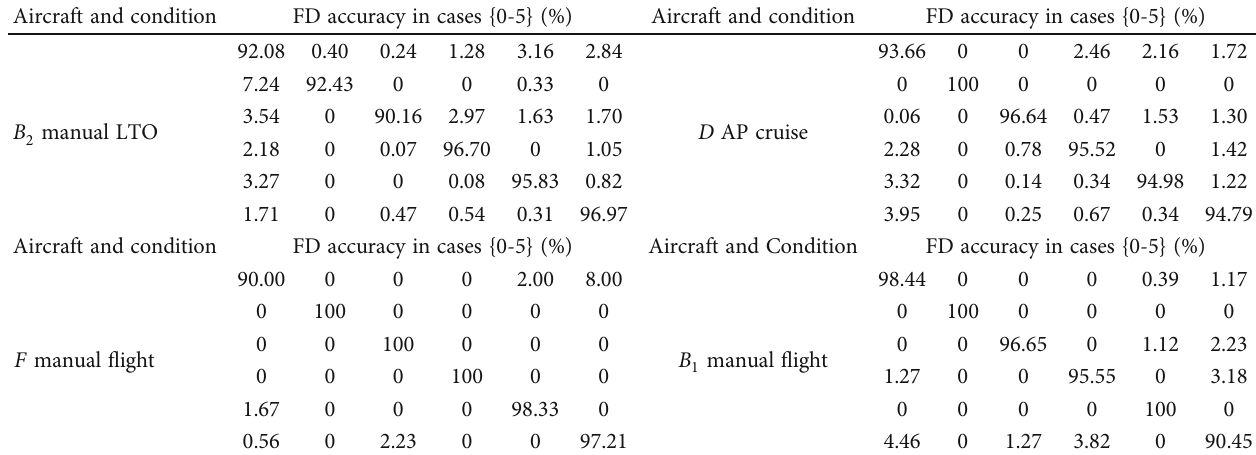
Table 7: Confusion matrix in testing the DNN-opt.